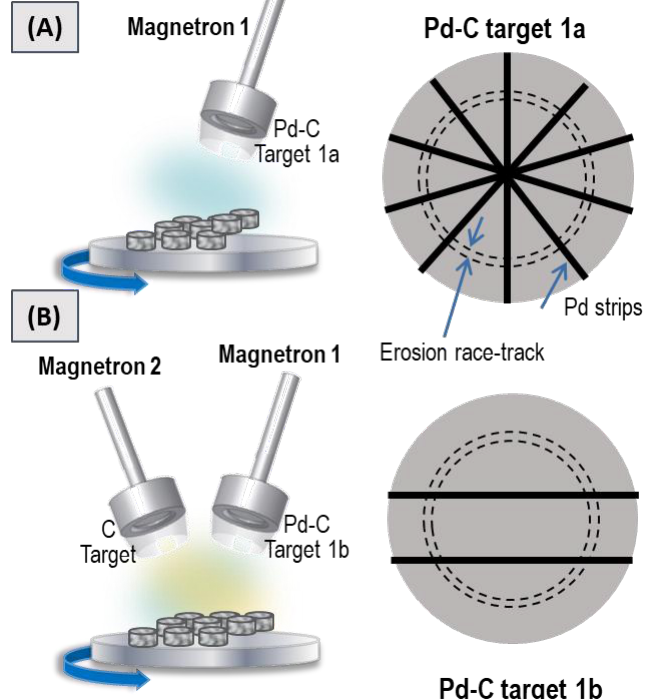
Figure 1. Scheme of the sputtering chamber and homemade Pd-C targets employed to prepare ( A ) 7C and 12C samples, and ( B ) the 65C sample.